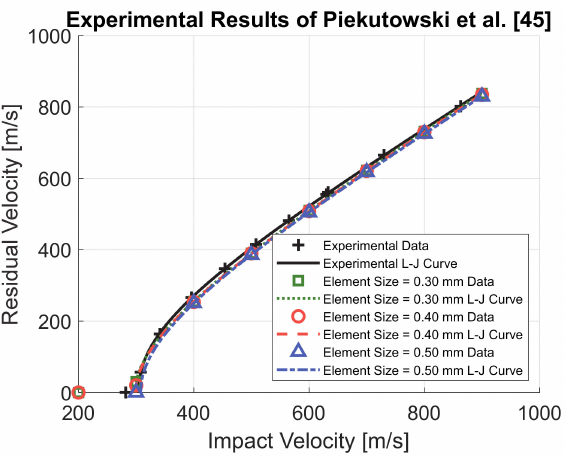
Figure 11. Validation of AA6061-T6 material model and mesh convergence